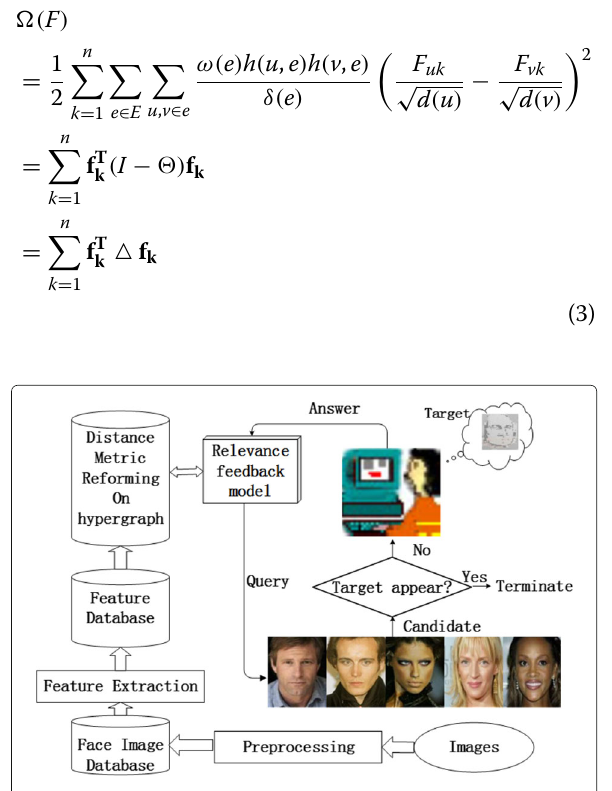
Fig. 3 The flowchart of interactive face